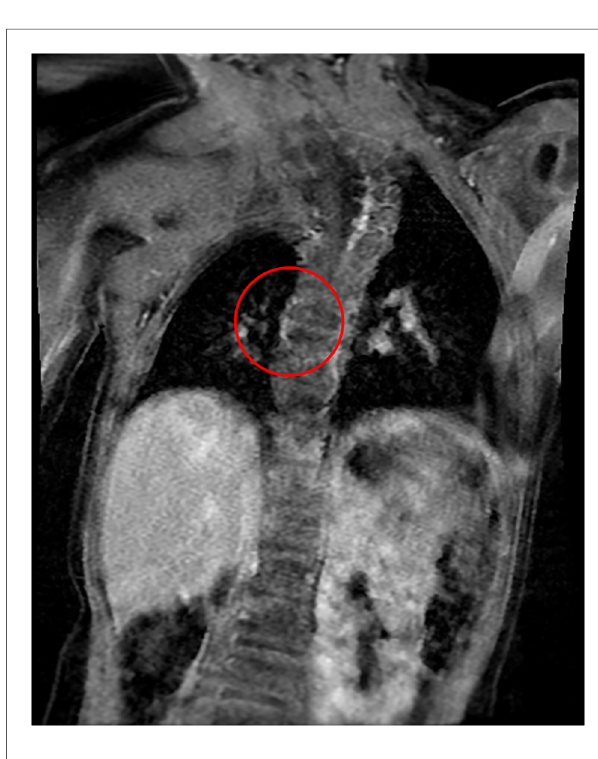
FIGURE 4 MRI scan 16 months after surgery (the circle shows no